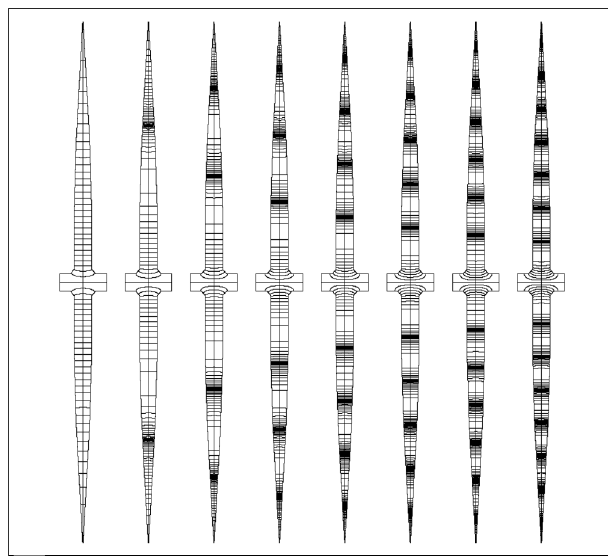
FIG. 1. The TM modes of the cavity bunch-length monitor through TM from TM 010 080